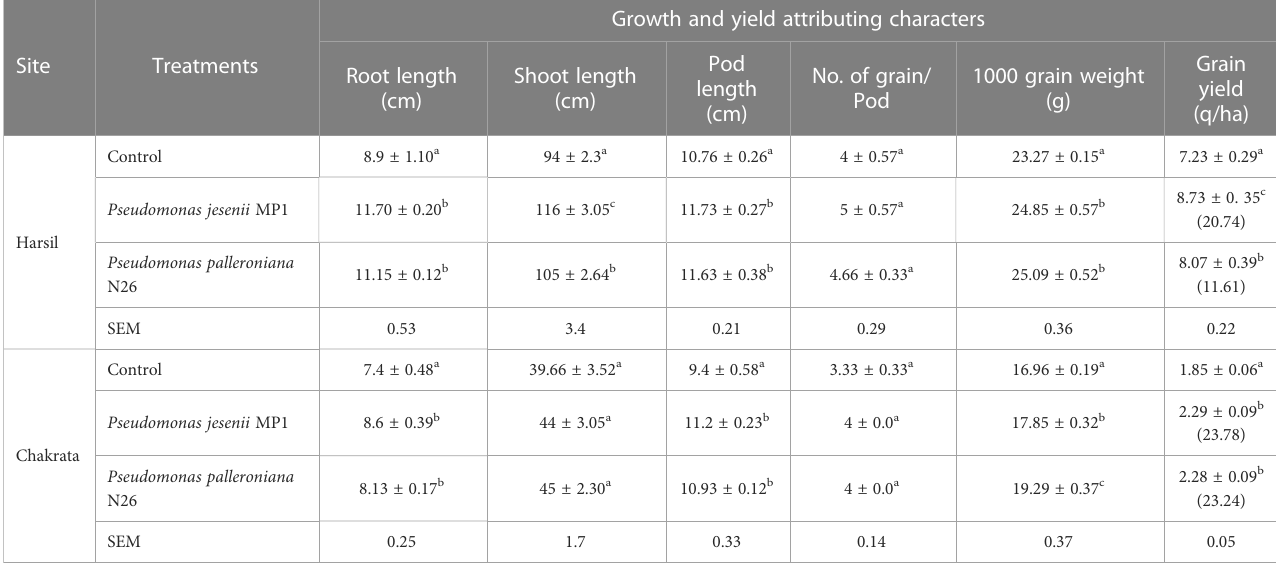
TABLE 2 Effect of Pseudomonas jesenii MP1 and Pseudomonas palleroniana N26 inoculation on growth and yield attributing characters of Kidney bean at Harsil and Chakrata.